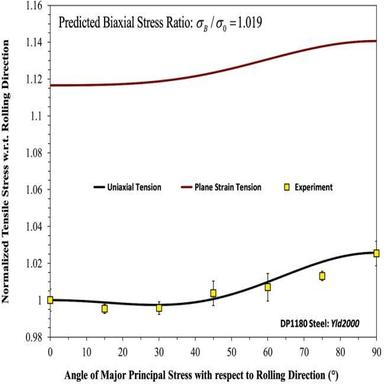
Experimental and predicted tensile stress ratios of DP1180 steel using the associated Yld2000 yield function. No experimental yield stress data was available for plane strain tension or equal-biaxial tension.